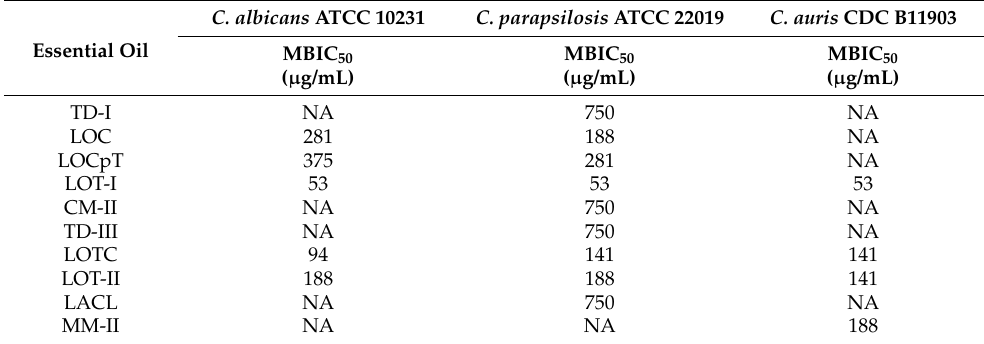
Table 3. MBIC 50 values for the most active EOs studied against C. albicans ATCC 10231, C. parapsilosis ATCC 22019, and C. auris CDC B11903 after 48 h of culture.